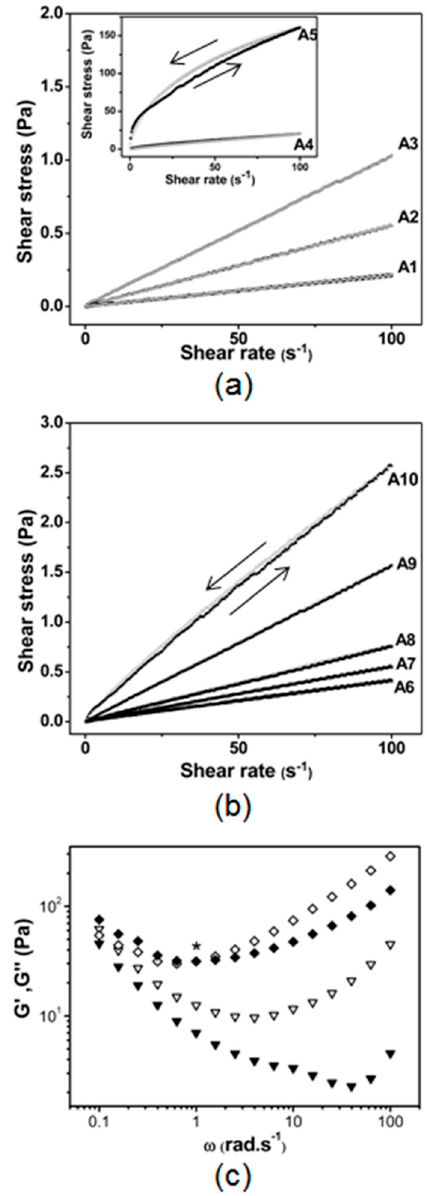
Figure 3. Effect of ( a ) SOR (A1 to A5) and ( b ) OWR (A6 to A10) on flow behavior; ( c ) viscoelastic behavior of non-Newtonian samples A4 ( ▼ ) and A5 ( ♦ ). Storage moduli (full symbol) and loss moduli (empty symbol) as a function of angular frequency. Note: the symbol * indicates the crossover.